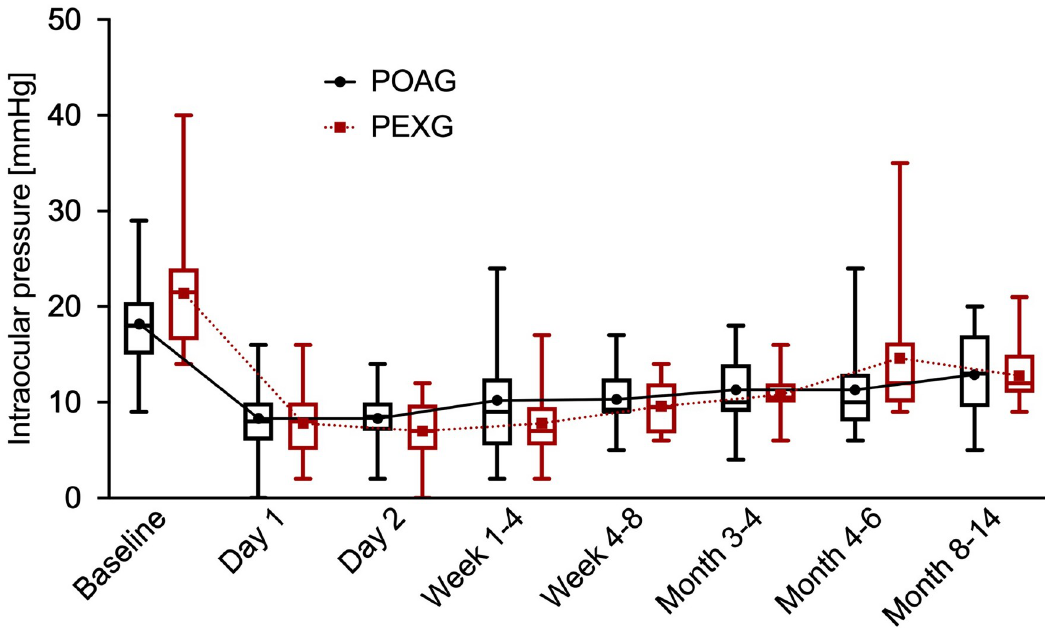
Fig 1. Intraocular pressure. Box and whisker plots of intraocular pressure preoperative and at each time of follow up for primary open angle glaucoma (POAG) and pseudoexfoliation glaucoma (PEXG). The middle lines indicate the median. The lower and upper ends of boxes indicate the lower and upper quartiles. Whiskers span from the absolute minimum to the absolute maximum. Additionally, mean values of intraocular pressure are shown, connected with a line.